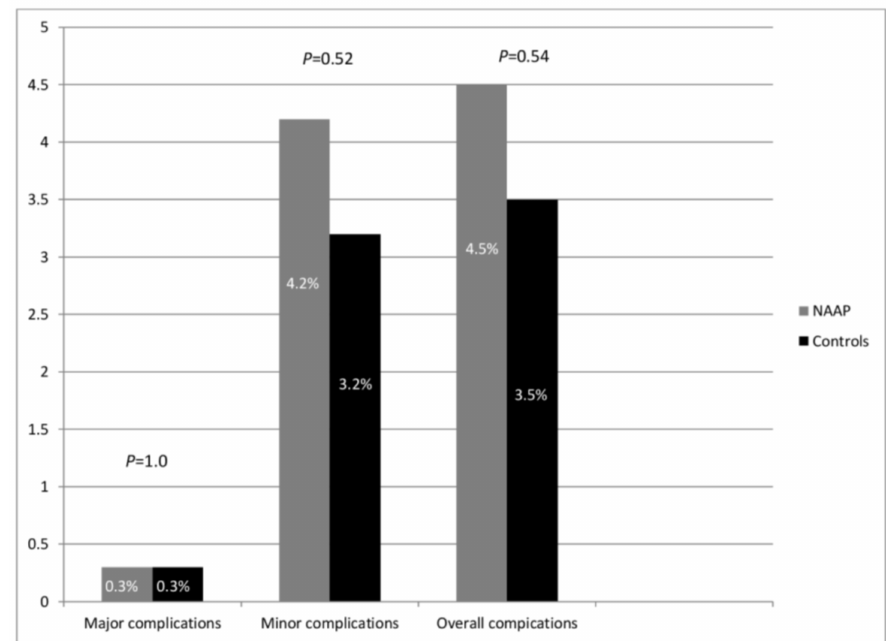
Figure 2. Comparison of major complication, minor complication, and overall complication rates between the two study groups. NAAP, Non-anesthesiologist administered propofol